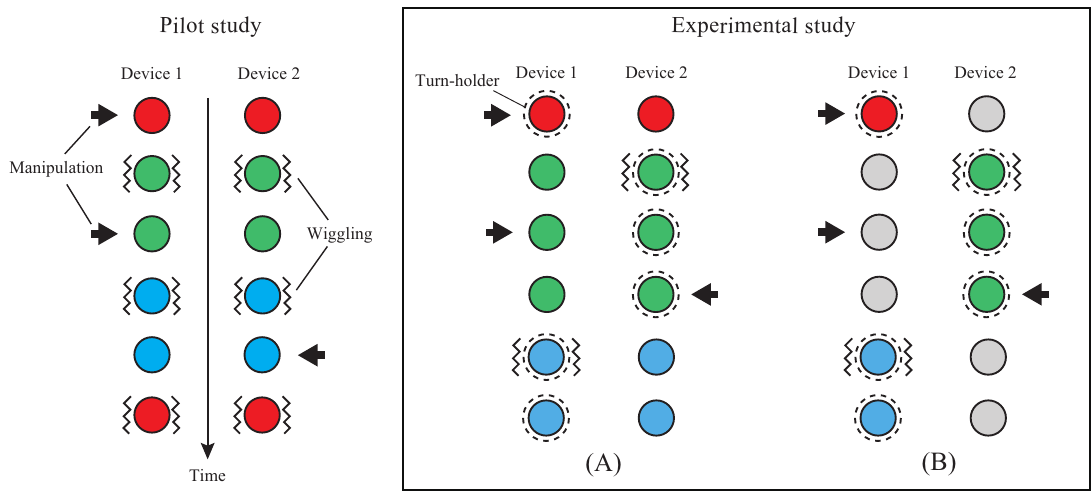
Figure 2. Three interaction rules for COLOLO: Previous rule [35] in which both devices always respond when manipulated (indicated by black arrows) and provide feedback through the change of light color and movements, ( A ) Two-sided lighting rule. The feedback with colored lights is always enabled for both devices and indicates the turn-holder through wiggling movements. A “turn” or “turn holder” refers to the device that is enabled to send a message to the paired device, ( B ) One-sided lighting rule. The colored-lights feedback is disabled (i.e., “off”) while the device is not holding the turn. In this rule, the device that is holding the turn is identifiable by lights and wiggling